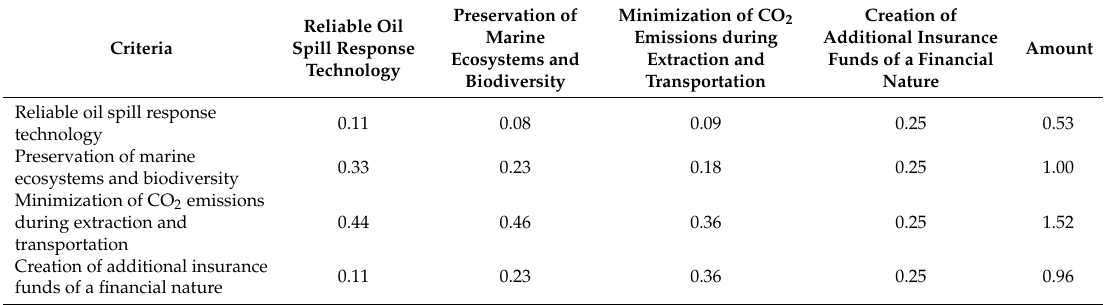
Table A11. Results of normalized assessment of the relative importance of environmental sustainability criteria.